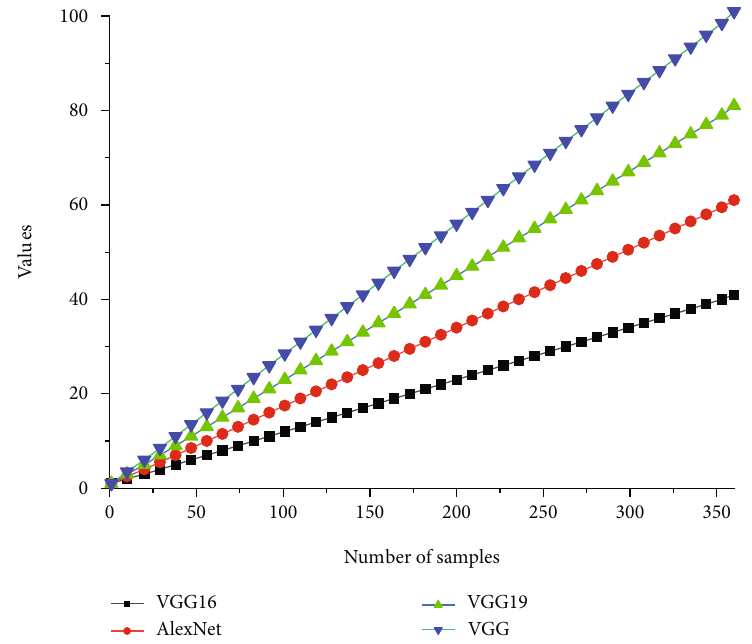
Figure 5: Classi fi cation accuracy (the outer value represents the corresponding name, and the inner dot represents the speci fi c